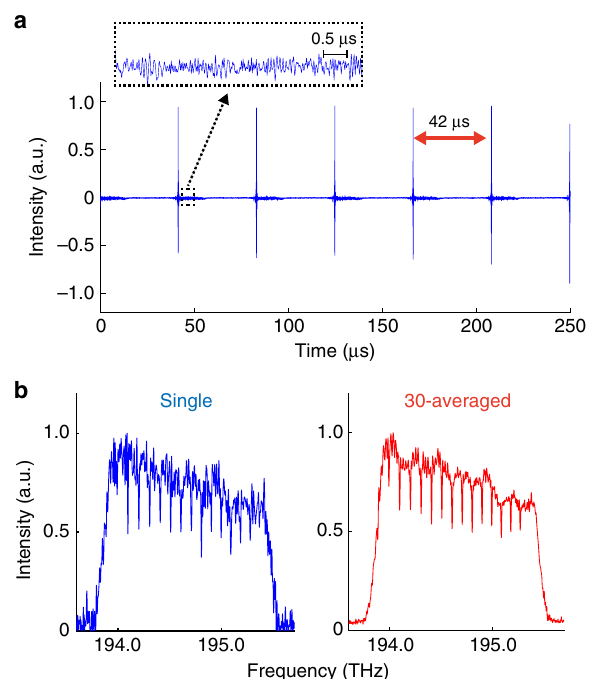
Fig. 6 Interferograms and spectra measured by the PC-FTS with the SLD. a Continuous interferograms of H 12 C 14 N molecules measured with the SLD at a scan rate of 24 kHz. b Spectra obtained by Fourier-transforming a single interferogram (left), and a 30-averaged